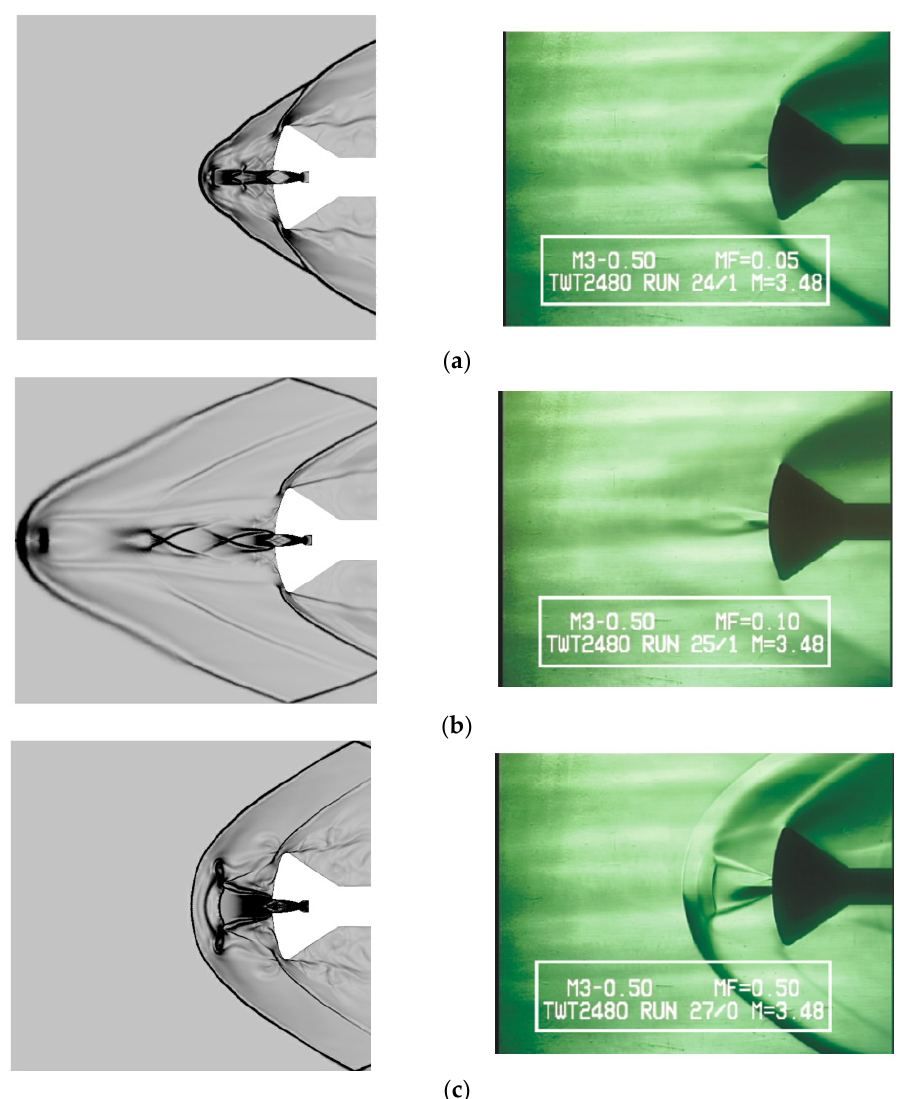
Figure 2. Experimental diagram of opposing jet structure: ( a ) Blunt penetration mode; ( b ) Long penetration mode; ( c ) Short penetration mode.